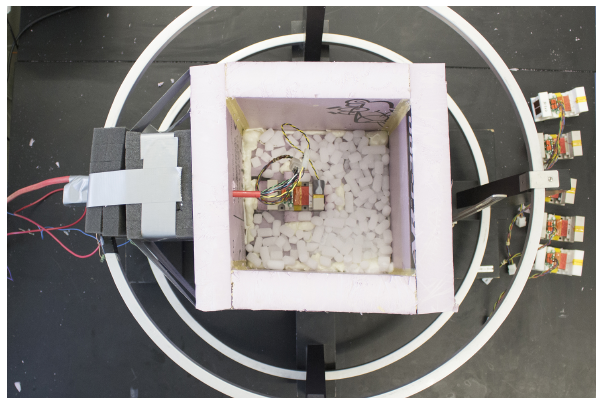
Figure 9. Sensor placed in a foam box within a Helmholtz coil. Dry ice was used to chill the sensor, and measurements were taken after the dry ice had sublimated and the sensor was slowly warming. The foam lid, plastic bag, and desiccant have been removed for the photograph.